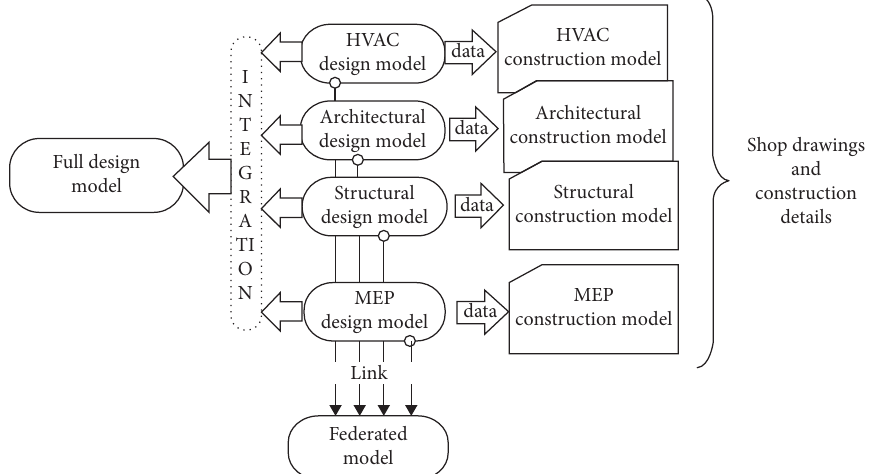
Figure 1: Diagrammatic representation of model definitions [19, 31, 32].